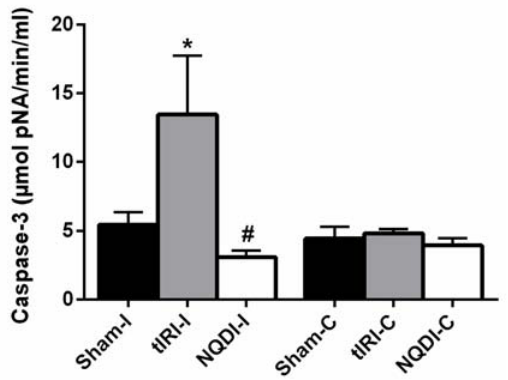
Figure 4. NQDI-1 attenuates Caspase 3 Activity. Utilizing a biochemical assay, tIRI-induced Caspase 3 Figure 4. NQDI ‐ 1 attenuates Caspase 3 Activity. Utilizing a biochemical assay, tIRI ‐ induced Caspase activitywasnormalizedbyNQDI-1treatmentandsimilartoshamlevels( p -value < 0.0001). Contralateral 3 activity was normalized by NQDI ‐ 1 treatment and similar to sham levels ( p ‐ value < 0.0001). testes showed no significant di ff erence between the three animal groups ( p -value > 0.05). NQDI-1 Contralateral testes showed no significant difference between the three animal groups ( p ‐ value > 0.05). (10 mg / kg) was i.p. injected 30 min post ischemia. Data are presented as mean ± SD ( n = 6 / group). NQDI ‐ 1 (10 mg/kg) was i.p. injected 30 min post ischemia. Data are presented as mean ± SD (n = * tIRI compared to sham and # NQDI-1 compared to tIRI. I = Ipsilateral and C = Contralateral. 6/group). * tIRI compared to sham and # NQDI ‐ 1 compared to tIRI. I = Ipsilateral and C = Contralateral. Protein expression of phosphorylated ASK-1(ph-ASK-1), ph-JNK, ph-p38 and survivin Protein expression of phosphorylated ASK ‐ 1(ph ‐ ASK ‐ 1), ph ‐ JNK, ph ‐ p38 and survivin were